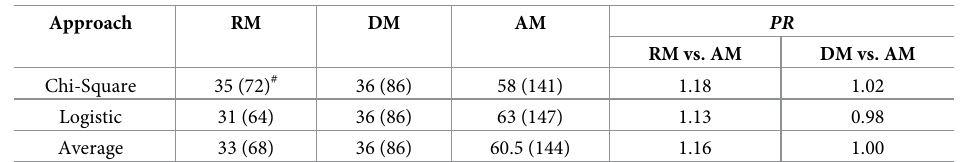
Table 2. Risk SNP counts and PR s on CAD.